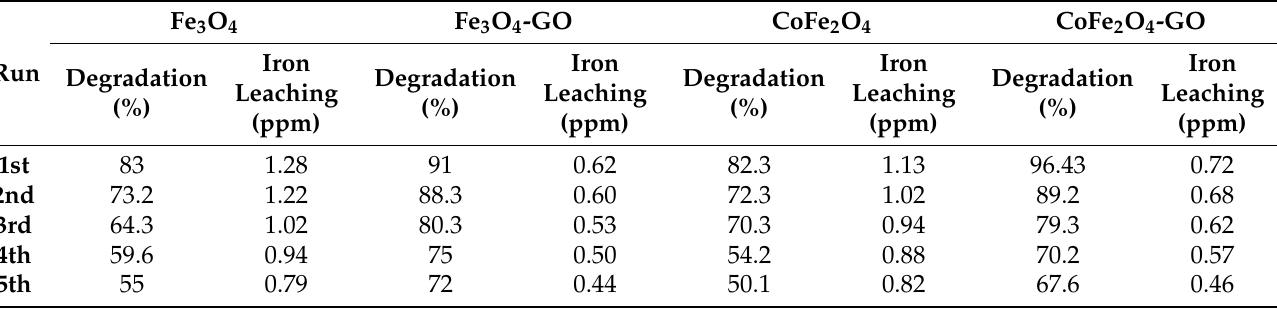
Table 1. Stability analysis catalysts in terms of Fe